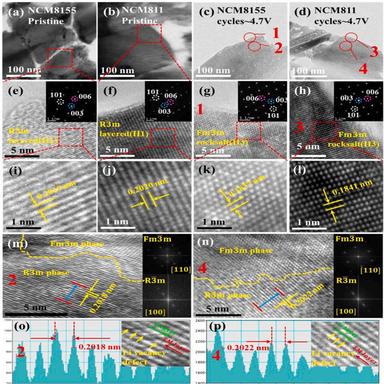
TEM image of NCM8155 and NCM811 original materials and after the 100th cycle is completed under voltage of 2.7–4.7 V; (a) Low magnification brightfield STEM image of primary particle section of NCM8155 before cycling; (e) The high-resolution bright-field TEM image and the corresponding selected area electron diffraction (SAED) image enlarged in the red line box in Figure (a); (i) The high-resolution image of the lattice fringe in the red line box in Figure (e). (c) Low magnification brightfield STEM image o